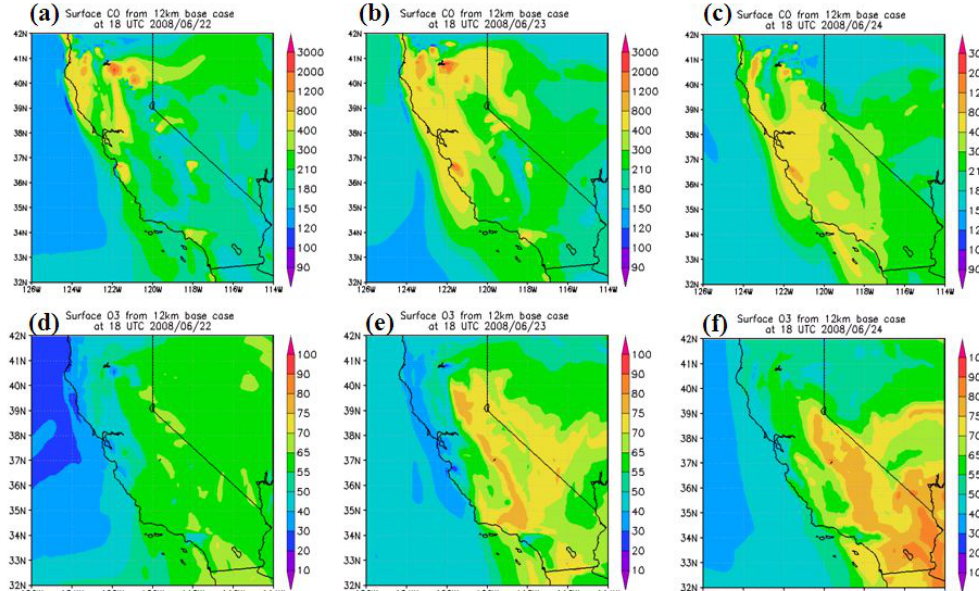
Fig. 4. 12km modeled surface CO (a–c) and O 3 (d–f) over California at 18:00UTC on 22 June (a; d), 23 (b; e) and 24 (c; f).